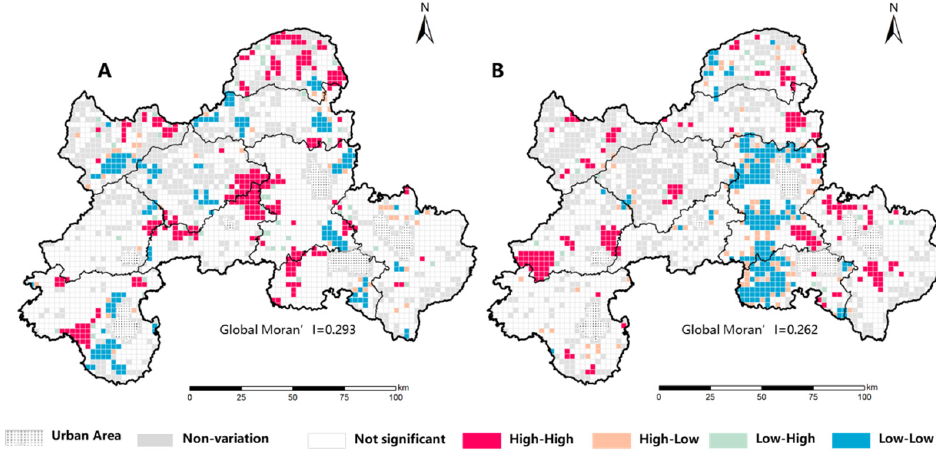
Figure 6. Maps to show significant ( p < 0.005) spatial clusters of the variation in cultivated land or rural residential land between 2009 and 2018 (( A ): cultivated land, ( B ): rural residential land).